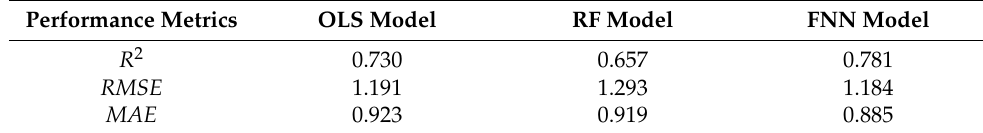
Table 3. Results of performance